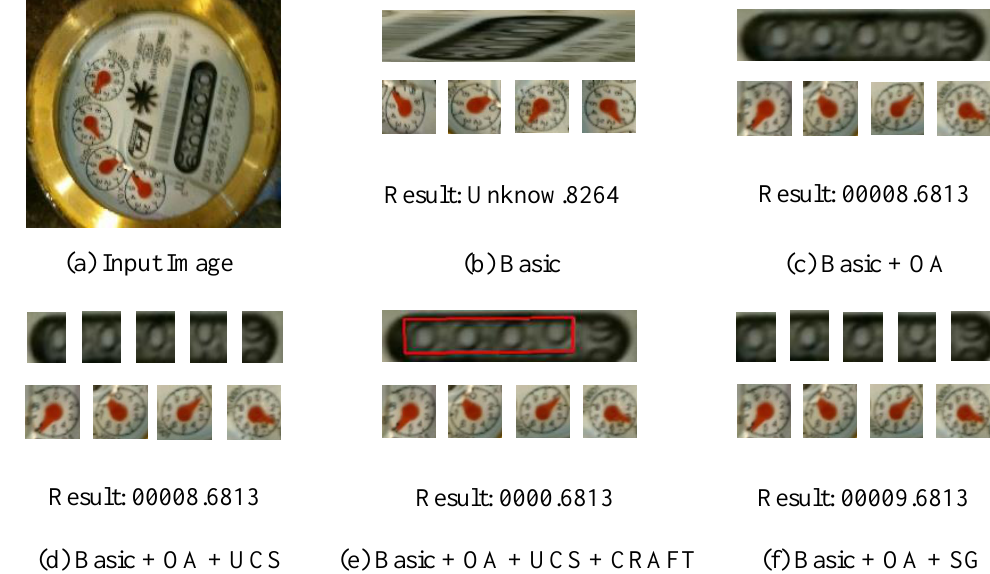
Figure 11. Visual comparison of different methods. “Basic + ” represents that we add different components to the baseline to the baseline network to read the watermeter